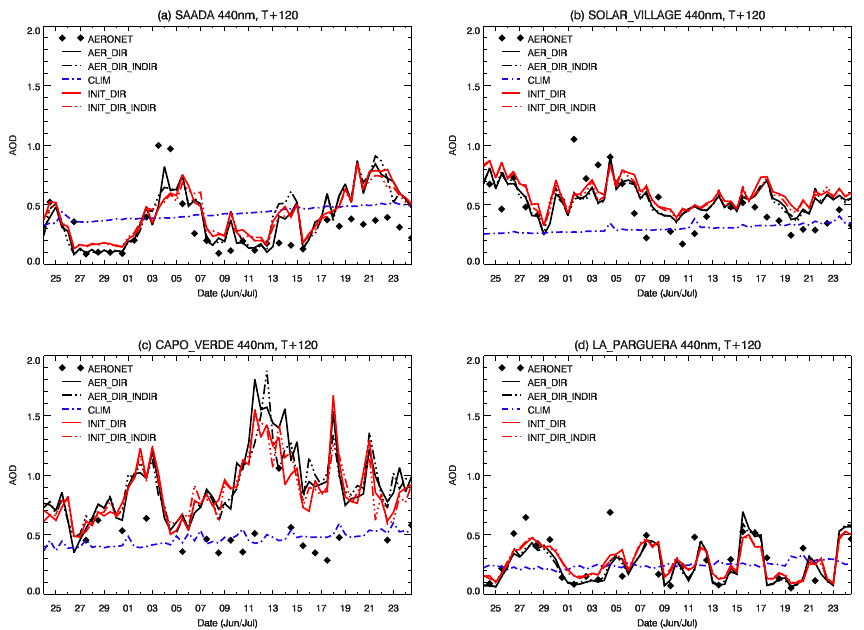
Fig. 3. Time series of T + 120 forecast AOD (440nm) in dust-prone locations: (a) Saada, (b) Solar Village, (c) Capo Verde and (d) La Fig. 3. Timeseries of T +120 forecast AOD (440 nm ) in dust prone locations (a) Saada, (b) Solar Village, (c) Capo Verde and (d) La Parguera.